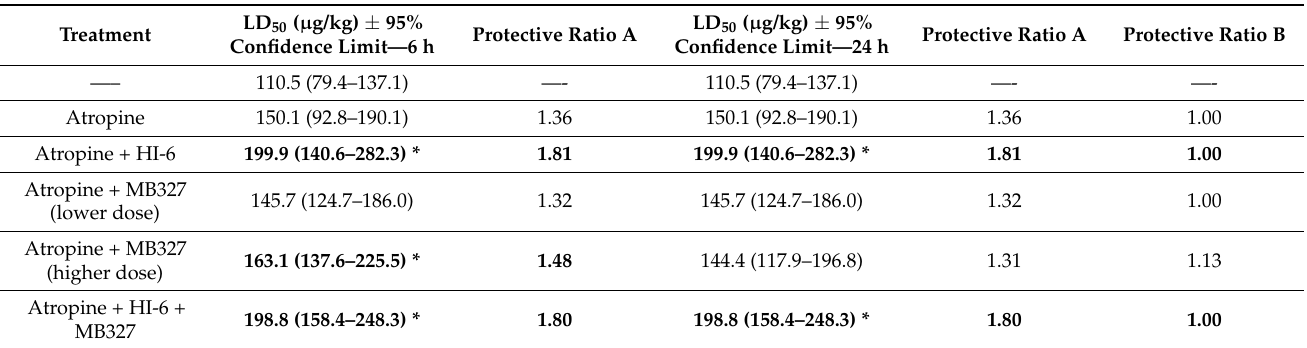
Table 2. The effect of experimental endpoint on the protection provided against the lethal effects of soman in mice.